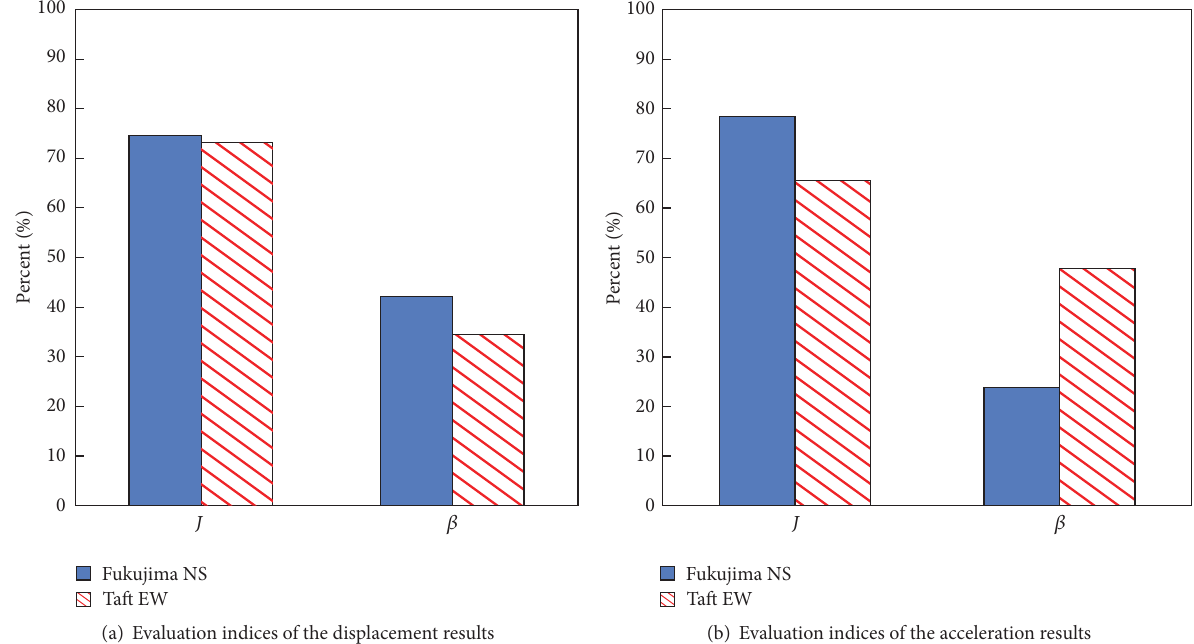
Figure 13: Experimental results for the evaluation parameters under Fukujima NS and Taft EW conditions: (a) evaluation indices of the displacement results and (b) evaluation indices of the acceleration results.